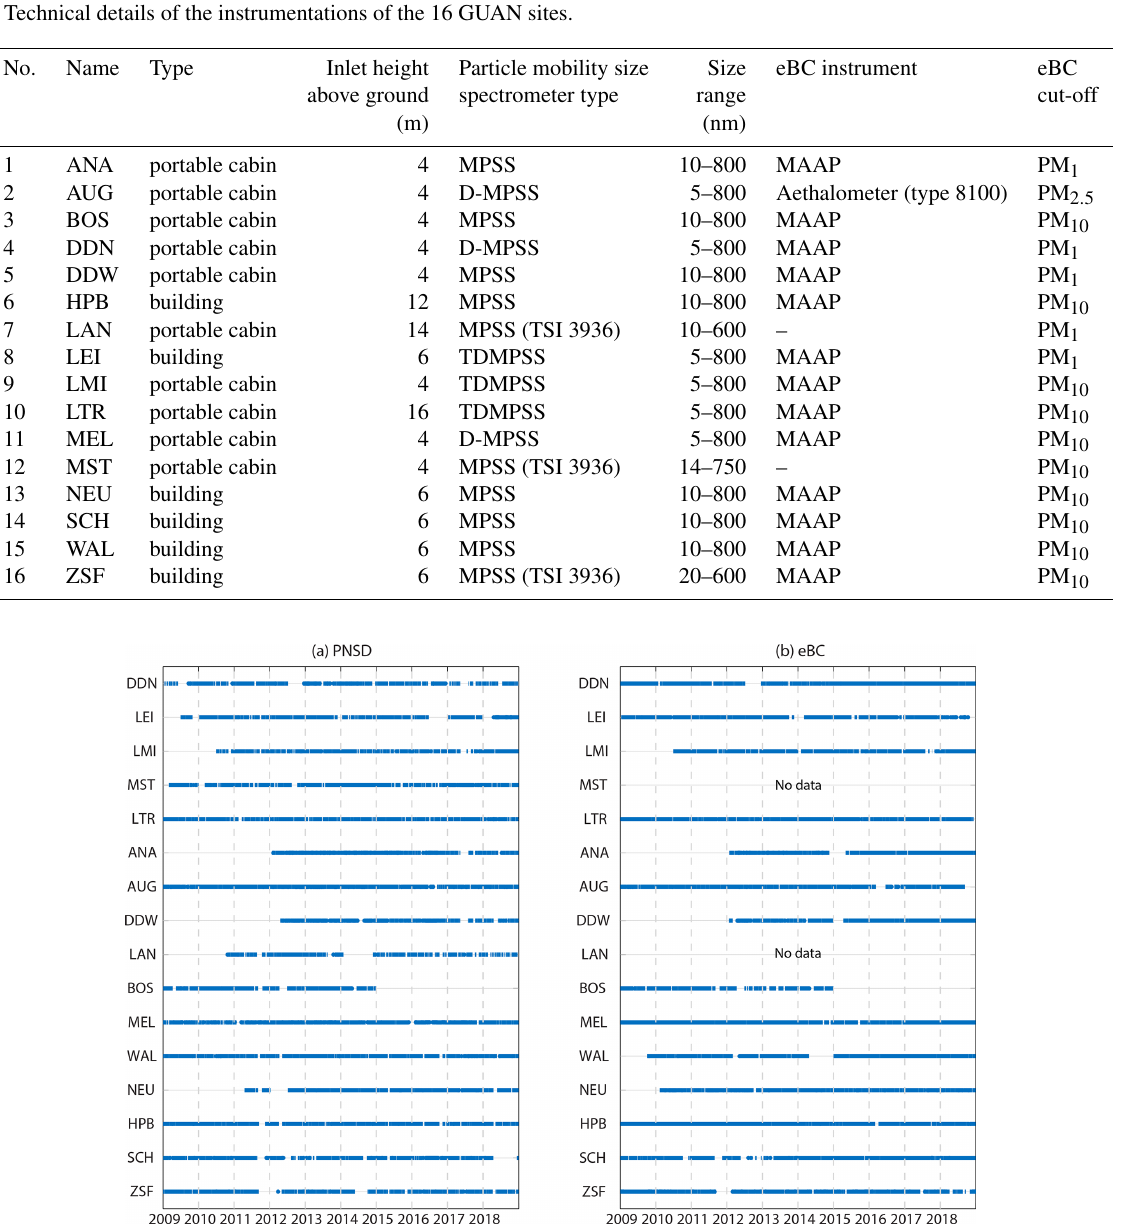
Figure 2. Data coverage of the PNSD and eBC mass concentrations from 2009 to 2018 at the 16 GUAN